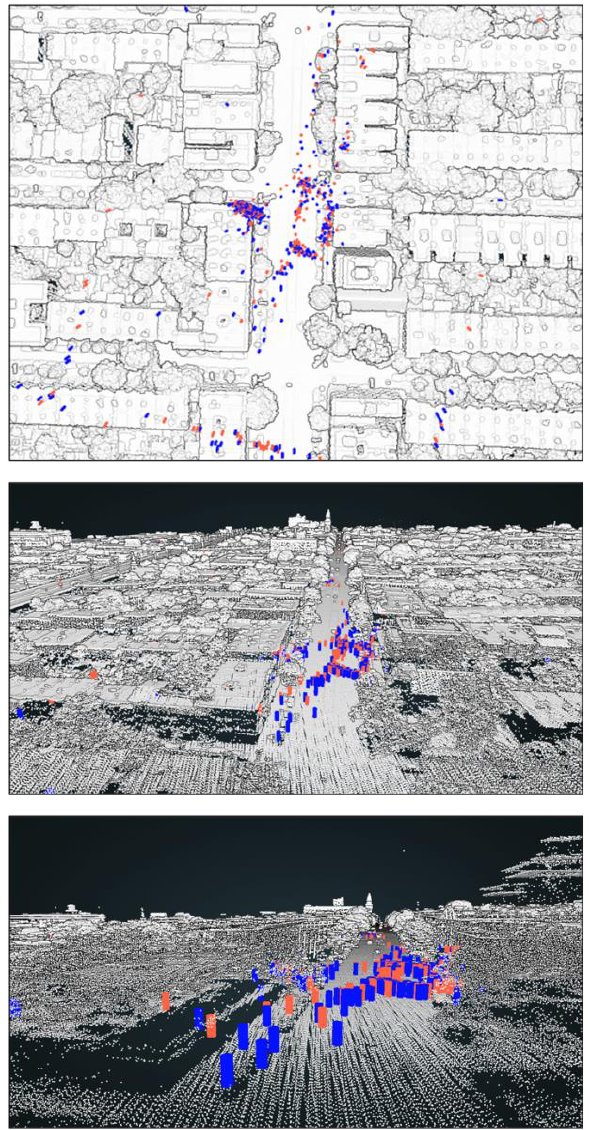
Figure 7. A set of 3D views of individuals in 3D space for NYU Langone Hospital, Brooklyn, USA. Medical personnel in green and others in pink (Displayed data for all 1578 points) visualizations provided the realistic depth to understand the individuals' location and also allowed the viewers to see into spaces by zooming and moving around the spaces. For example, (1) the gender feature was displayed using different colors to distinguish between the movement patterns among males and females (Fig 6). (2) the medical personnel feature was selected, and the implemented color shading represented the differences in proportion of healthcare workers from non-medical personnel (Fig 7). The high volume of non-medical individuals when compared with the limited number of healthcare workers illustrated the dire situation during the COVID-19 pandemic with all the healthcare workers strained for